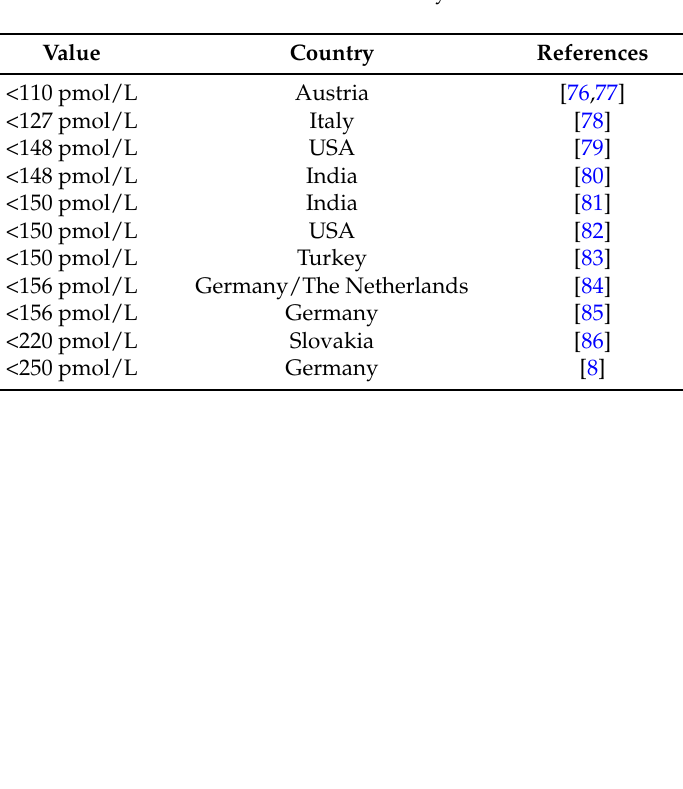
Table 1. Vitamin B12 deficiency